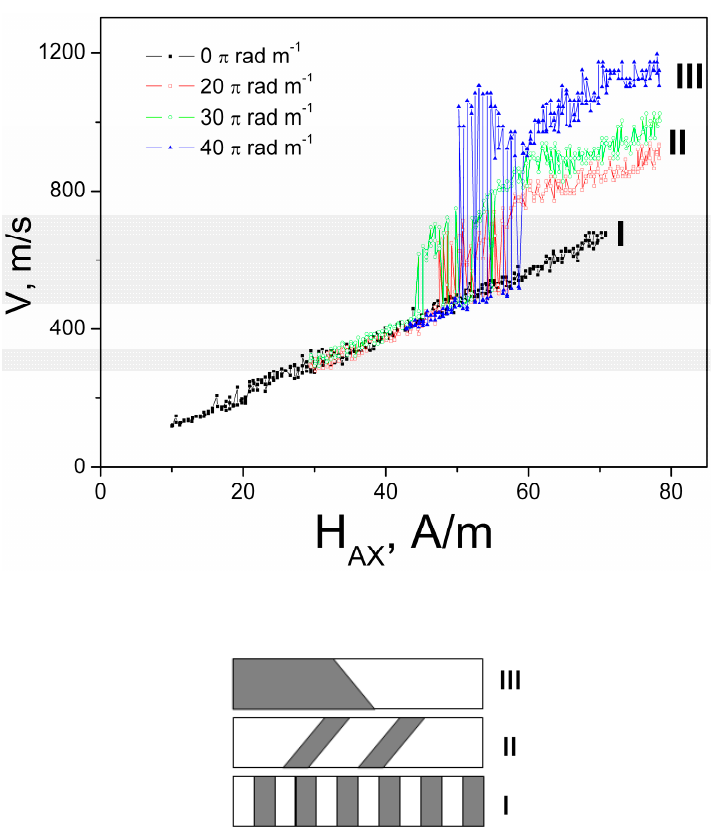
Figure 4. Dependencies of velocity of domain wall on axial magnetic field for different values of torsion stress τ and schematic images demonstrate three types of domain structure. Reprinted with permission from [17].